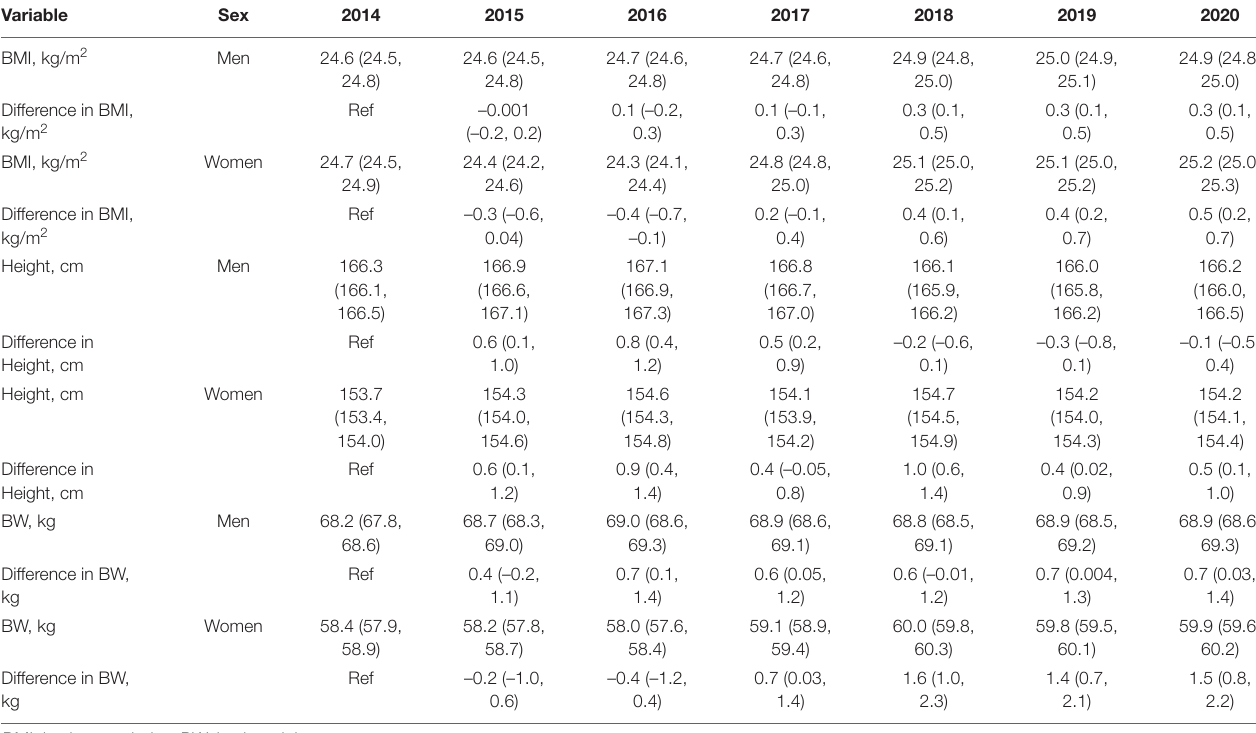
TABLE 3 | Trends in anthropometric parameters in 50,192 Chinese aged participants from 2014 to 2020. Variable